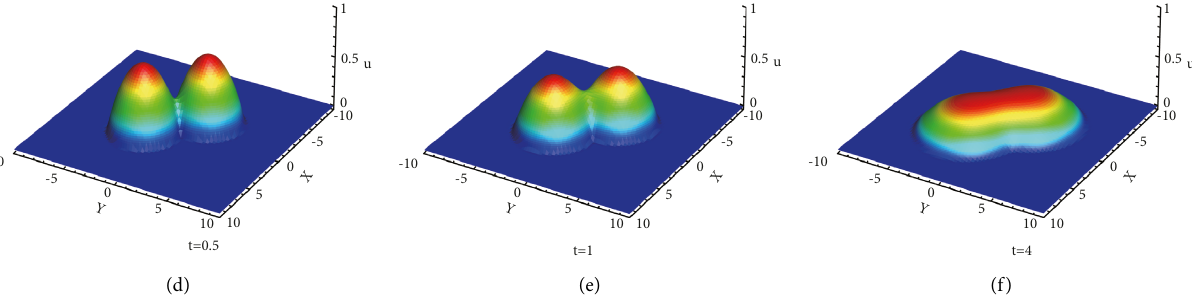
Figure 8: Example 7. 2D PME. CRUS-WENO scheme (top); WENO-JS scheme (bottom). 80 × 80 grid points.